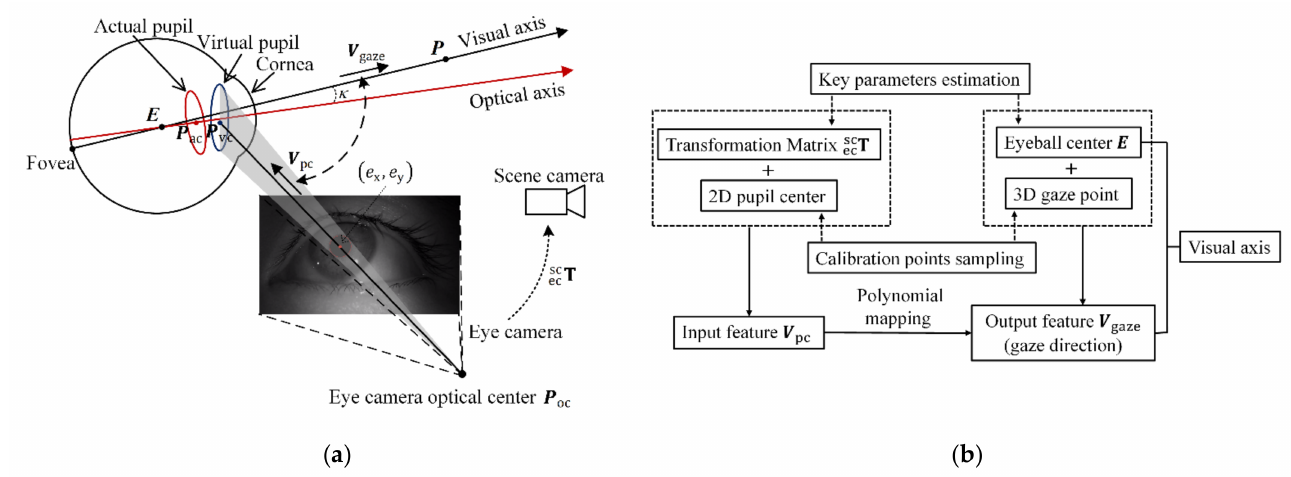
Figure 1. Illustration of gaze estimation model. ( a ) Each eye image feature (2D pupil center) corre- sponds to a vector V pc which is used as the input feature to calculate the vector V gaze . Noted that E is assumed as the intersection of all visual axes. ( b ) Flowchart of the model